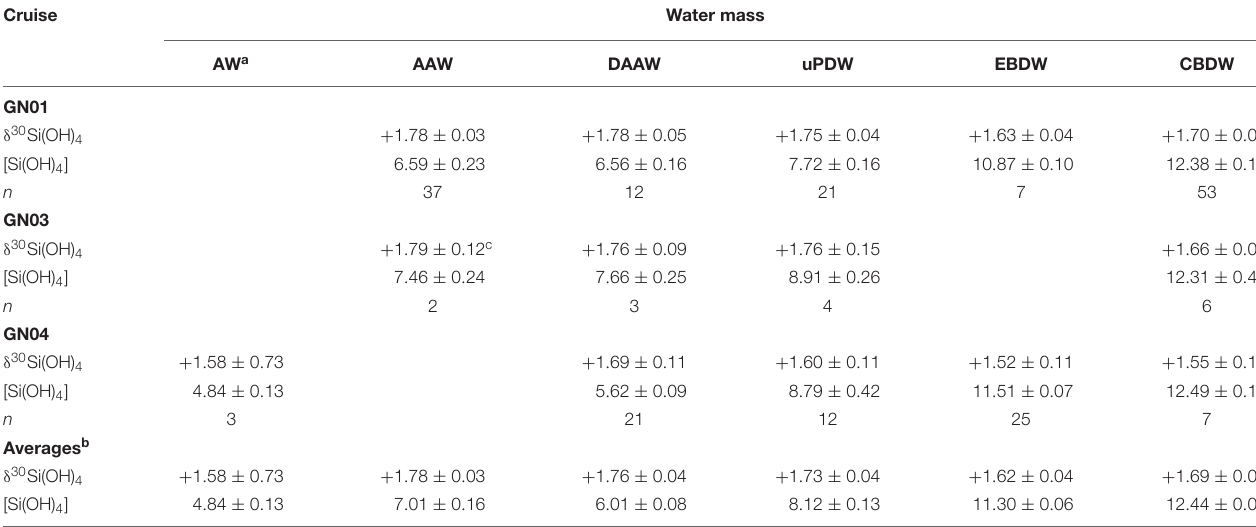
Cruise Water mass AAW